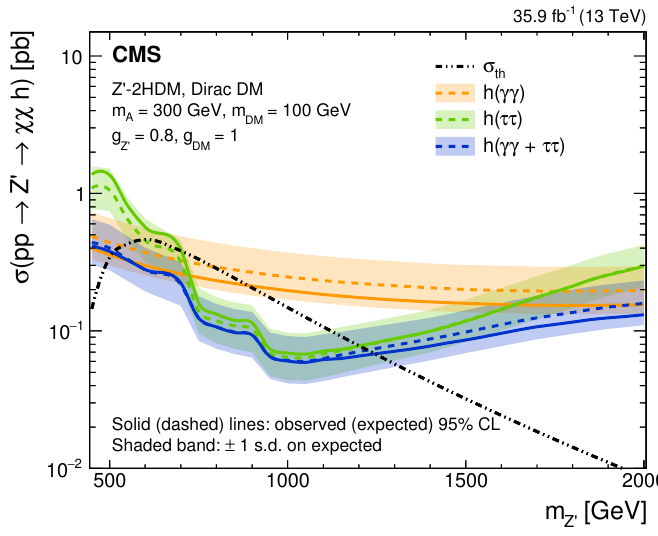
Figure 5 . Expected and observed 95% CL upper limits on the Z -2HDM cross section for dark 0 matter associated production with a Higgs boson (Z ! (cid:31)(cid:31) h) are shown. Limits are given for the 0 h ! (cid:13)(cid:13) channel, h ! (cid:28) + (cid:28) channel, and their combined (cid:0)